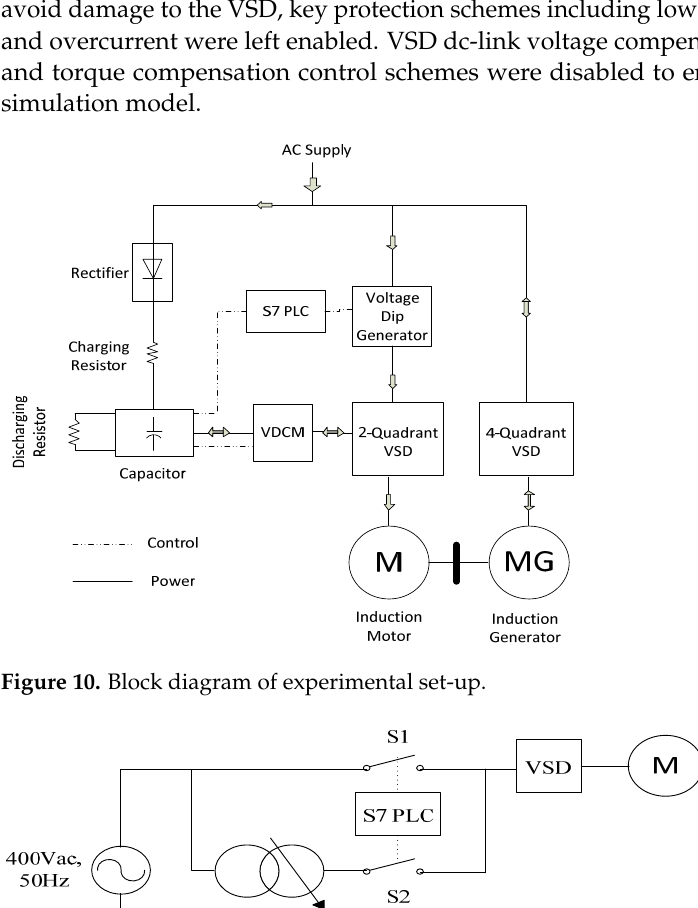
Figure 11. Voltage dip generator.